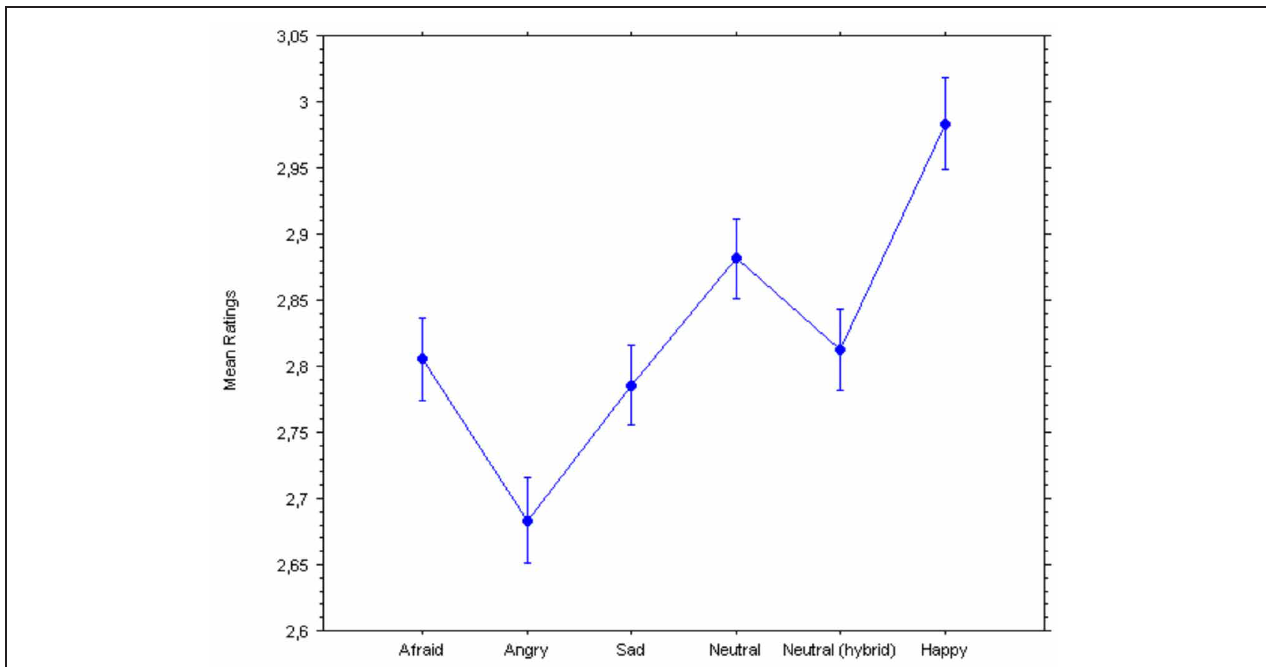
FIGURE 2 | Ratings of pleasantness of hybrid faces. Bars represent 95% confidence intervals for within-subject designs (Loftus and Masson, 1994).